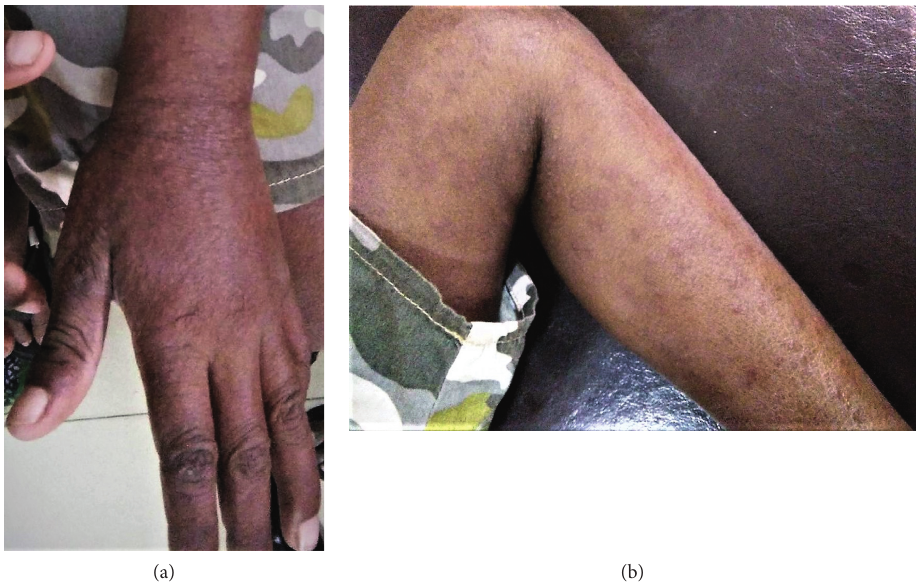
Figure 1: Exfoliative dermatitis in the upper limb (a) and the lower limb (b) which was initially presented as an erythematous nonblanching maculopapular